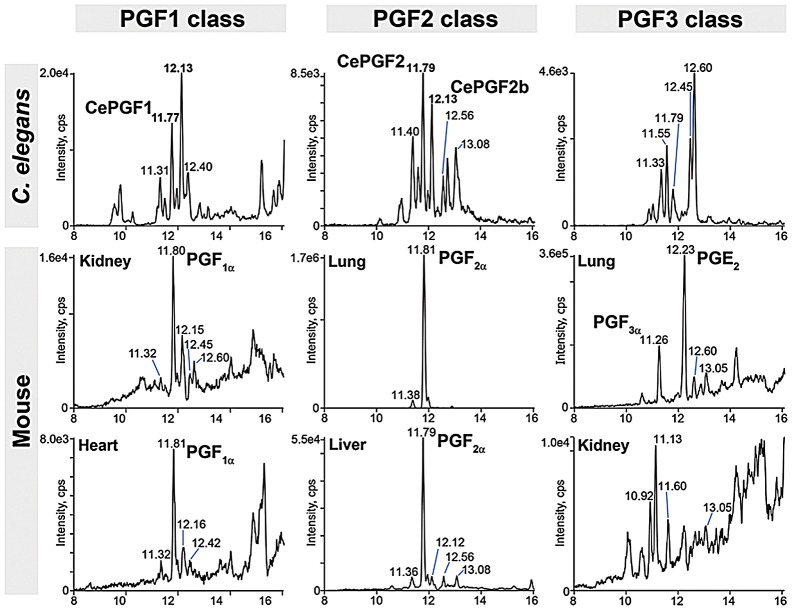
F-series prostaglandins in C. elegans and mouse tissues.MRM chromatograms comparing F-series prostaglandins in C. elegans and mouse tissue extracts. The F1 class was detected with mass transition m/z 355/311, the F2 class was detected with mass transition m/z 353/193, and the F3 class was detected with mass transition m/z 351/193. Liquid chromatography retention time (min) is shown on the X-axis and for selected prostaglandin isomers. Cps, counts per second. The C. elegans MRM chromatograms are from Figure 3A. The mouse lung is extremely rich in PGE2, which was detectable with mass transition m/z 351/193.